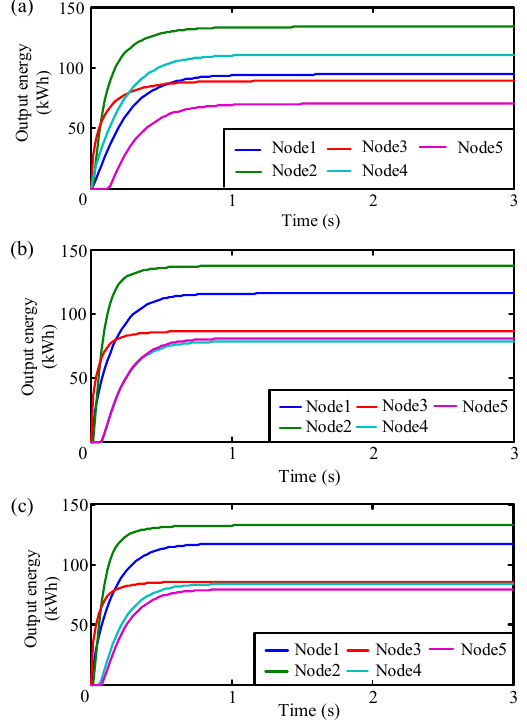
Figure 8. Output energy Q agg ,i in the upper layer for ( a ) the optimal allocation method based on the consensus incremental cost, ( b ) the average allocation method and ( c ) the battery-capacity-based allocation method. Figure 7 and Figure 8 indicate that the system reached a steady state in a short time. At the same time, the energy storage clusters could realize the optimal energy allocation according to the distributed control strategy. No matter which method was used, energy can be efficiently allocated to each node in the upper layer with its optimal cost. The information of each node under different energy allocation methods is shown in Table 5. Table 5. The energy information of each node under different allocation methods. Node Optimal Allocation Based on the Consensus Incremental Cost (kWh) Average Allocation (kWh)